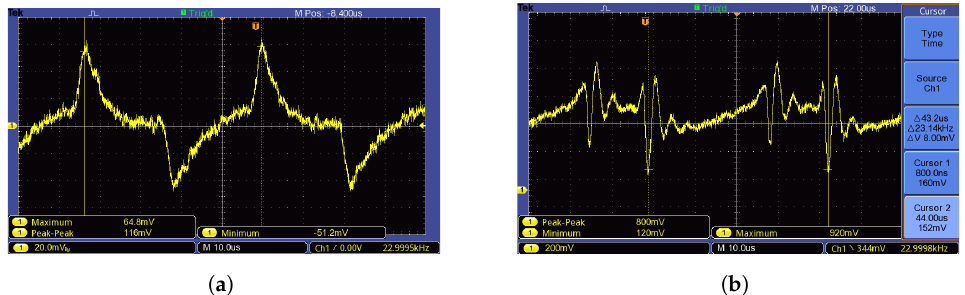
Figure 13. The supply current as a result of voltage drop measurement at PRC 2 affected by leaking control voltage ( a ). The same measurement with suppressed crosstalk between control voltage of VCO and supply voltage of VCO ( b ).